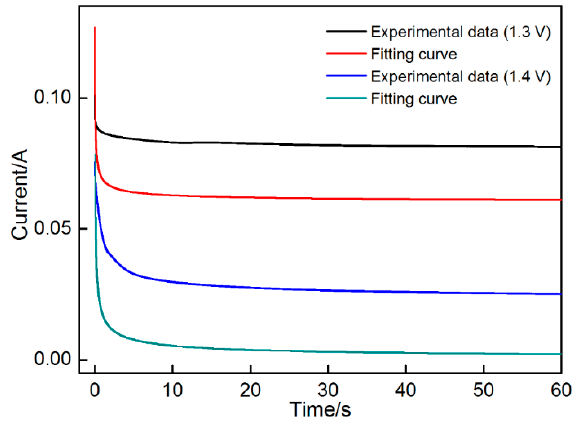
Figure 2. Chronoamperograms obtained on nickel foam.